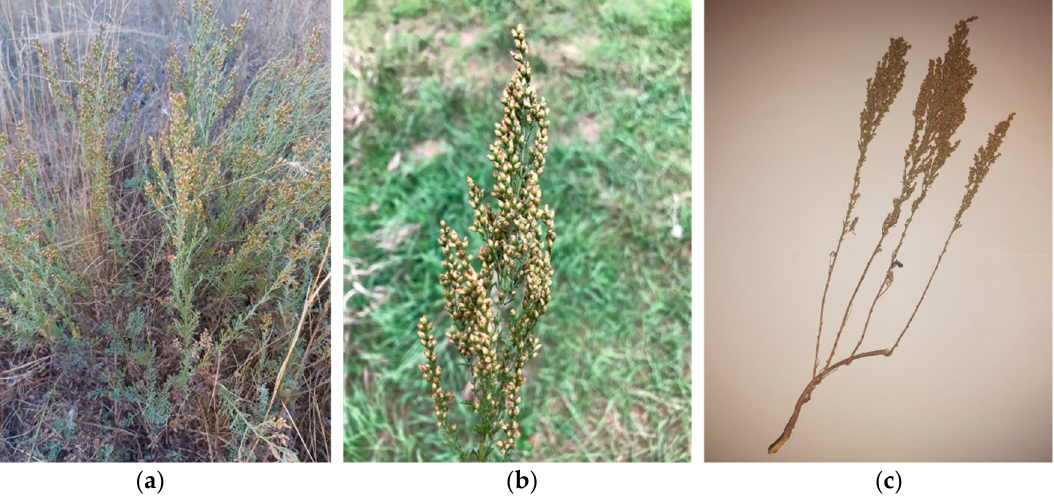
Figure 1. Artemisia campestris subsp. lednicensis (Spreng.) Greuter & Raab-Straube. ( a ) In its natural habitat, near Aroneanu Lake (Iasi county, Romania); ( b ) inflorescence; ( c ) herborized plant material (Photo by Adriana Trifan).